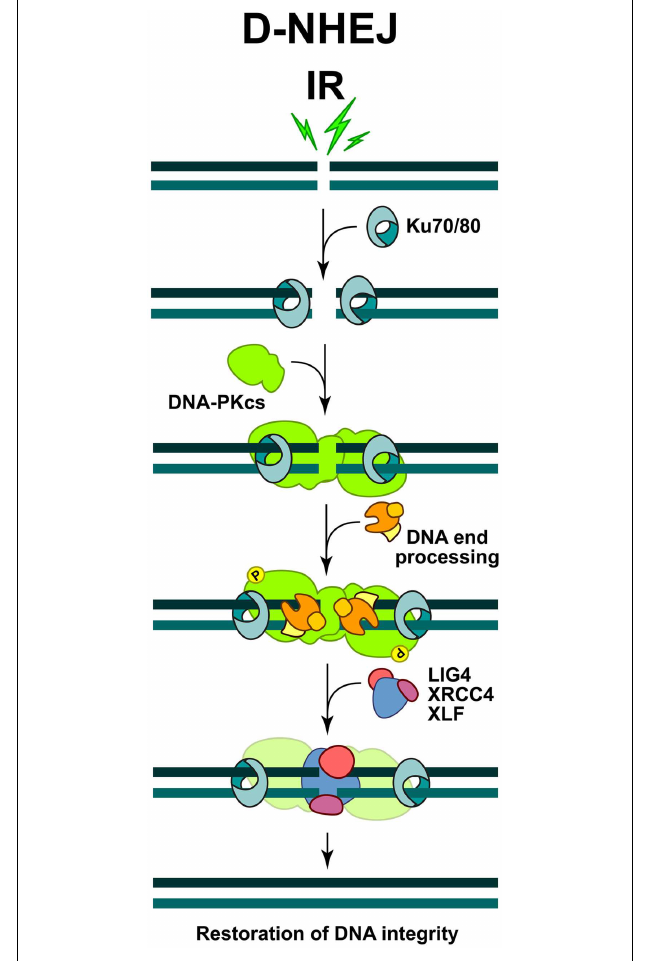
FIGURE 1 | Schematic representations of DSB repair by non-homologous end-joining .The process is initiated by the binding of KU heterodimer to the DNA ends, which then recruits DNA-PKcs to form an active DNA-PK holoenzyme. DNA-PK activation helps the recruitment of multiple proteins involved in the limited DNA end-processing (Artemis, pol µ , pol λ , andTDK) required to generate ligatable DNA ends. Ligation is mediated exclusively by the LIG4/XRCC4 complex and is assisted by the ligation mediator XLF. At the end of this process the DNA integrity at the break is restored, but the DNA sequence at the junction may be